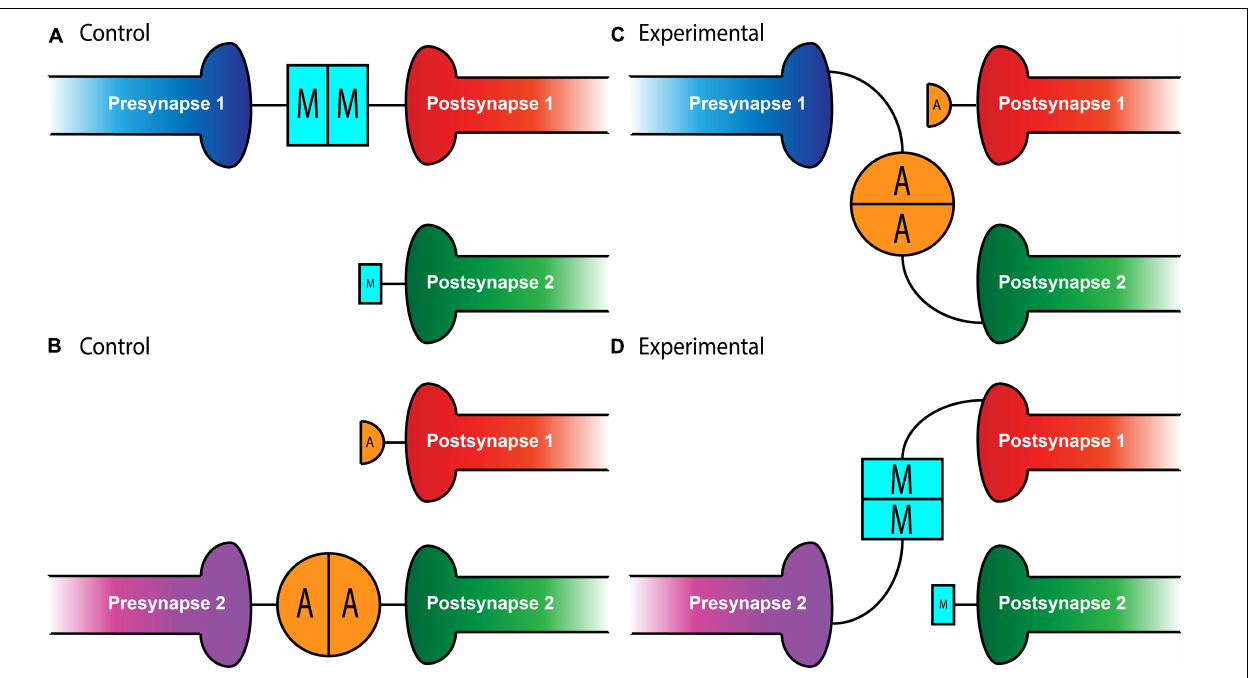
FIGURE 1 | Teneurin-mediated partner matching in the CNS and PNS. Elevated levels of Teneurin expression control partner matching between distinct subsets of presynaptic neurons and their cognate postsynaptic partners. Normally, Presynapse 1 (either a motoneuron or ORN axon) with high levels of Ten-m matches with Postsynapse 1 (either a muscle or PN dendrite) expressing high levels of Ten-m, denoted here with a larger blue square (A) . Presynapse 2 with high levels of Ten-a matches with Postsynapse 2 expressing high levels of Ten-a, shown above with a larger orange circle (B) . In conditions where Teneurins are mis-expressed, alterations in wiring can occur. Experimental overexpression of Ten-a in the neuron of Presynapse 1 causes it to match with Postsynapse 2 which is also expressing high Ten-a instead of Postsynapse 1 (C) . Overexpression of Ten-m in the neuron of Presynapse 2 causes it to match with Postsynapse 1 instead of its normal partner, Postsynapse 2 (D)